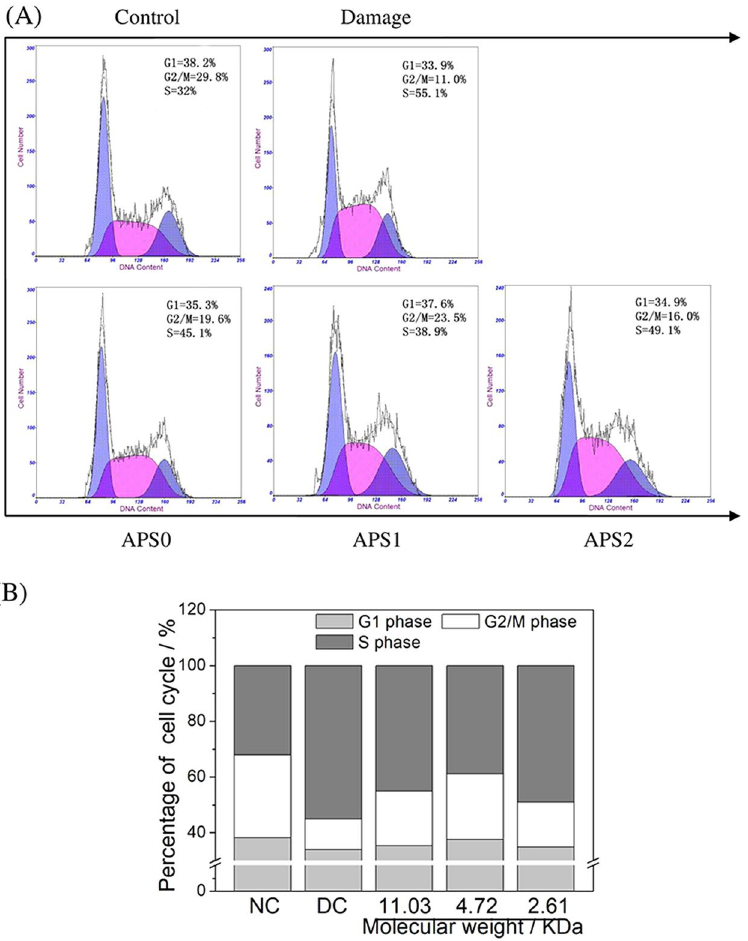
Figure 7. Cell cycle changes of oxalate damaged HK-2 cells after repair by different Mw APS (60 μ g/mL) for 10 h. ( A ) Cell cycle results detected by flow cytometry; ( B ) the percentage of cells in the G1, G2/M and S